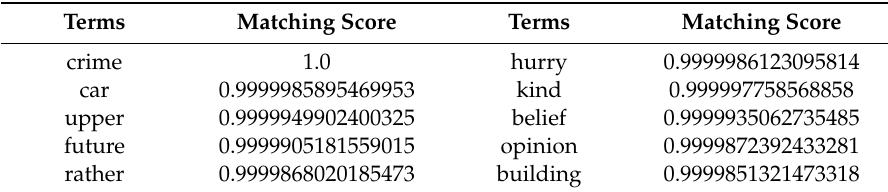
Table A3. Top terms for term crime.